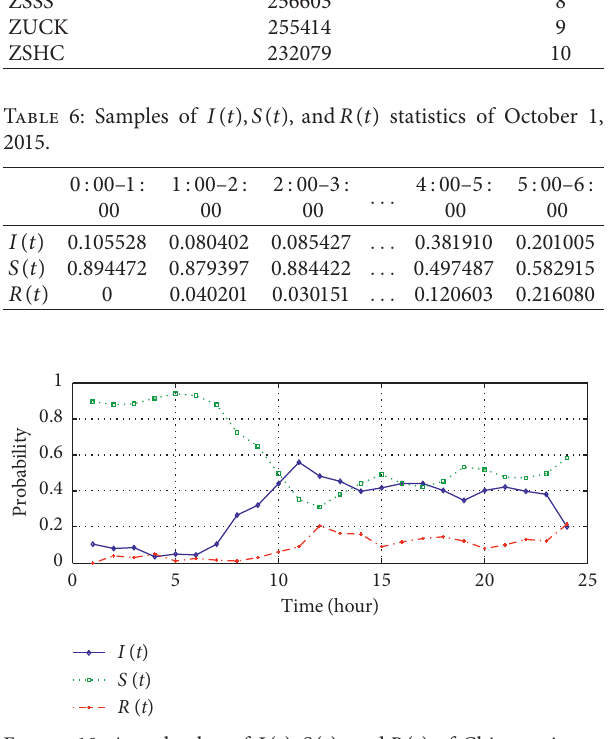
Figure 10: Actual value of I ( t ) , S ( t ) , and R ( t ) of Chinese airport network.